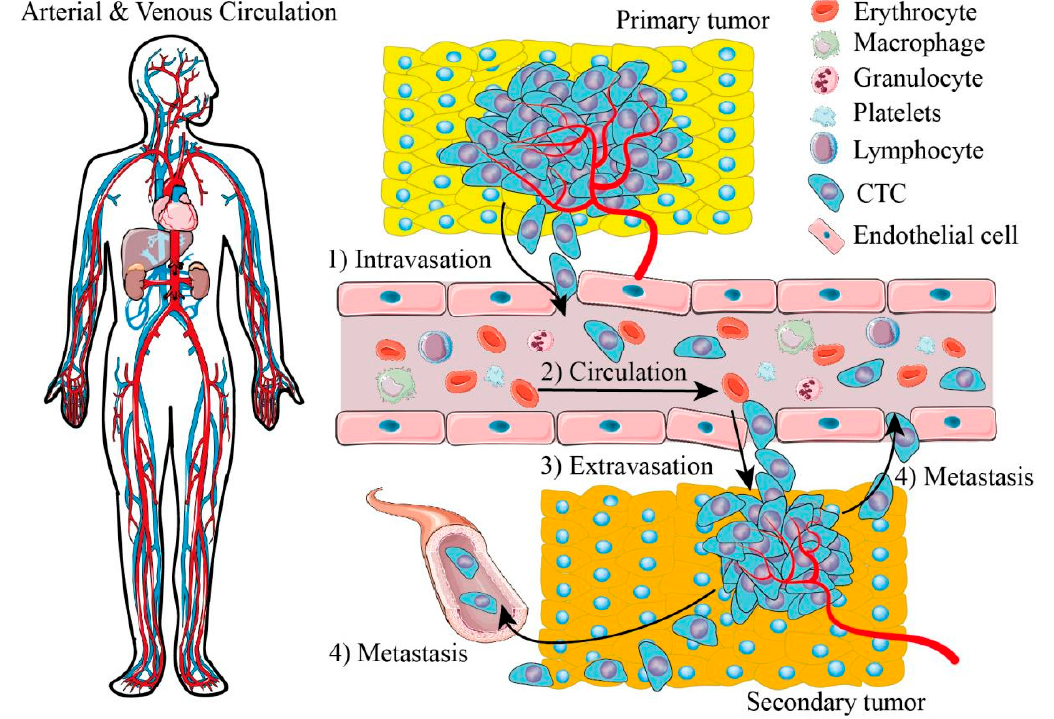
Figure 1. Illustrations of arterial and venous circulation and cancer metastasis. (1) Tumor cells of primary tumors invade endothelium. (2) Tumor cells circulate in blood vessels with blood cells, called circulating tumor cells (CTCs). (3) CTCs evacuate from blood vessels and invade a distant position to constitute a secondary tumor. (4) Tumor cells of secondary tumors invade blood vessels again to build another tumor